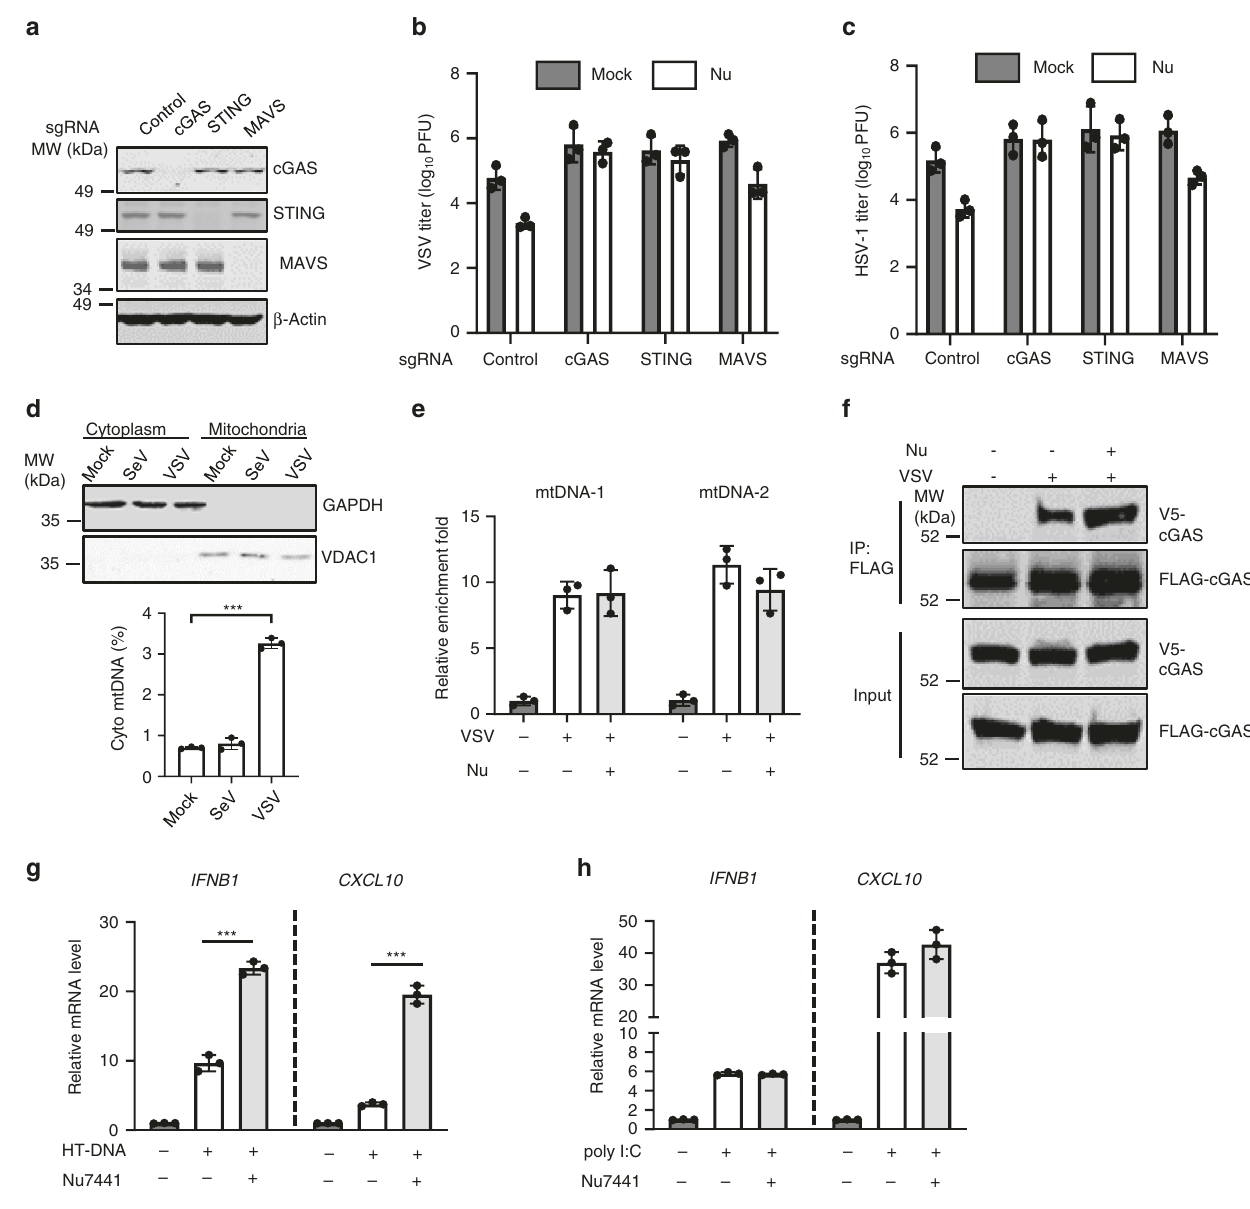
Fig. 3 DNA-PK inhibition enhances cGAS-mediated antiviral immune responses. a THP-1 cells were transduced with sgRNA targeting the indicated genes to generate knockout cells. WCLs were analyzed by immunoblotting with the indicated antibodies. b , c THP-1 cells as described in a were mock treated or treated with Nu7441 (3 μ M) and infected with VSV ( b ) or HSV-1 ( c ) (MOI = 0.01). Viral titer in the medium at 24 hpi was determined by plaque assays. d THP-1 cells were infected with SeV (20 HAU/ml) or VSV (MOI = 5). Cytoplasmic and mitochondrial compartments were analyzed with the indicated antibodies and cytoplasmic mitochondrial DNA (mtDNA) was extracted and quanti fi ed by real-time PCR at 6 hpi. p = 5 × 10 − 6 . e 293T cells stably expressing FLAG-cGAS were mock treated or treated with Nu7441 (3 μ M) and then were mock infected or infected with VSV (MOI = 0.01) for 16 h. WCLs were precipitated with anti-FLAG agarose and the precipitated DNA was analyzed by Real-Time PCR with mtDNA-speci fi c primers. f 293T cells stably expressing FLAG-cGAS and V5-cGAS were mock treated or treated with Nu7441 (3 μ M) and then were mock infected or infected with VSV (MOI = 0.01) for 16 h. WCLs were precipitated with anti-FLAG agarose. Precipitated proteins and WCLs were analyzed by immunoblotting with the indicated antibodies. g , h THP-1 cells were treated with Nu7441 (3 μ M) and transfected with HT-DNA or poly I:C (1 μ g/ml). The expression of the indicated genes was analyzed by real-time PCR. g IFNB1 : p = 9 × 10 − 5 , CXCL10 : p = 3 × 10 − 5 . All experiments were done at least twice, and one representative is shown. n = 3 biologically independent samples for b – e , g , h . Data are presented as mean values ± SD. Center and error bars denote mean and SD. *** p < 0.005, two-tailed Student ’ s t test. Source data are provided as a Source data fi cGAS are the major DNA-PK phosphorylation sites in vitro. In vitro kinase assay indicated that wild-type (WT) cGAS was Next, we generated antibodies speci fi cally recognizing phos- signi fi cantly phosphorylated by DNA-PK, while the phosphor- phorylated T68 and S213 of cGAS that demonstrated exquisite ylation of T68E and S213D mutants was greatly reduced speci fi city (Supplementary Fig. 4f). Using these phospho-speci fi c (Supplementary Fig. 4e). Double mutations of T68E and S213D antibodies, we showed that cGAS was phosphorylated at T68 and further decreased cGAS phosphorylation by DNA-PK (Supple- S213 upon VSV or HSV-1 infection (Fig. 4e and Supplementary mentary Fig. 4e). These results indicate that T68 and S213 of